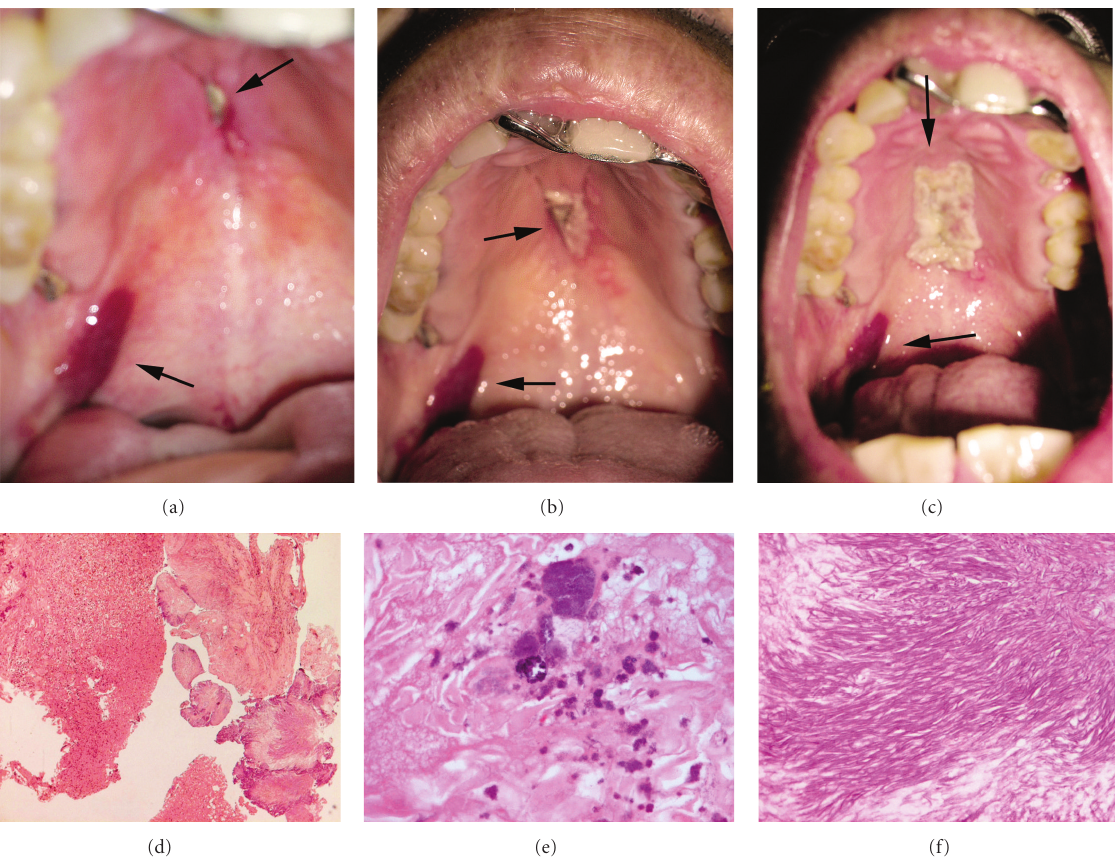
Figure 1: Top row (a) Day 0, biopsy performed: a sessile, whitish lesion of 4-5mm in diameter is observed in the middle line of the hard palate (upper arrow). There is a violet plaque-like lesion, measuring 1 × 0.8 cm in diameter, compatible with Kaposi’s sarcoma on the right side of the soft palate (lower arrow). (b) Day 3: the lesion extended causing erosion of the palatal bone. (c) Day of hospital admission and initiation of treatment (day 7): the palatal lesion extended, measuring 2 × 1 cm in diameter, presenting necrotic tissue, sulphur granules (and erosion of the palatal bone but in absence of nasal cavity fistula. Bottom row. (d) 10x view of the palatal lesion biopsy by hematoxylin eosin staining, showing actinomyces bacteria. (e) 40x magnification of the sulphur granules. (f) 40x magnification of hyphae-like actinomyces strings in the palatal specimen. Digital art disclaimer: for best identification of relevant features, images were adjusted for contrast, brightness, intensity, and saturation, but no brush strokes or similar manipulations were carried out, except for the line art arrows and